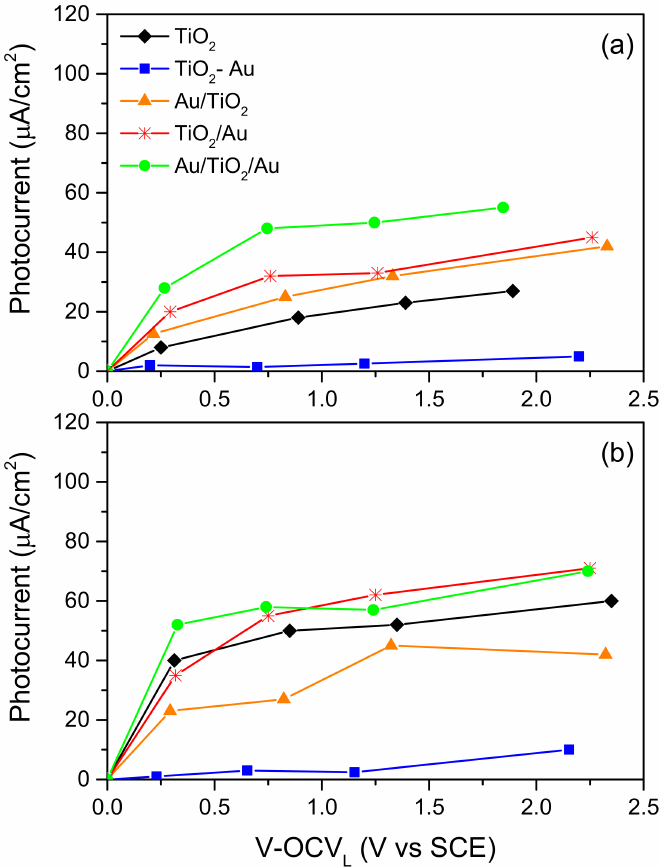
Figure 4. Trend of photocurrent densities as a function of the overpotential with respect to OCV L , measured in ( a ) supporting electrolyte and in ( b ) 50 ppm BPA